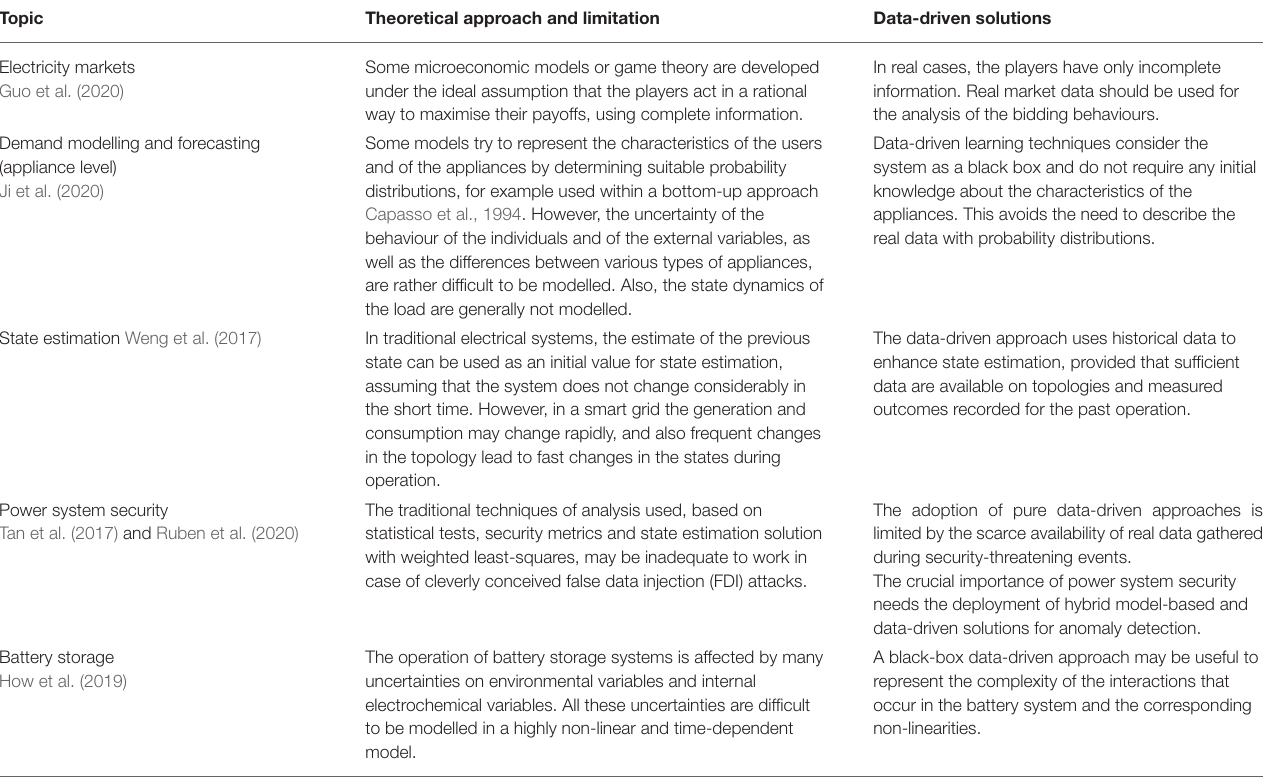
TABLE 2 | Some limitations of existing models and possible data-driven